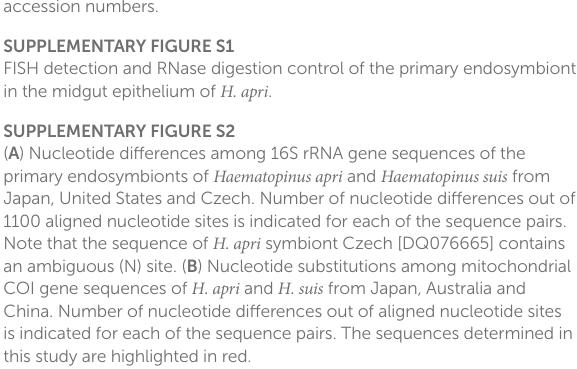
SUPPLEMENTARY FIGURE S1 FISH detection and RNase digestion control of the primary endosymbiont in the midgut epithelium of H. apri . SUPPLEMENTARY FIGURE S2 ( A ) Nucleotide differences among 16S rRNA gene sequences of the primary endosymbionts of Haematopinus apri and Haematopinus suis from Japan, United States and Czech. Number of nucleotide differences out of 1100 aligned nucleotide sites is indicated for each of the sequence pairs. Note that the sequence of H. apri symbiont Czech [DQ076665] contains an ambiguous (N) site. ( B ) Nucleotide substitutions among mitochondrial COI gene sequences of H. apri and H. suis from Japan, Australia and China. Number of nucleotide differences out of aligned nucleotide sites is indicated for each of the sequence pairs. The sequences determined in this study are highlighted in